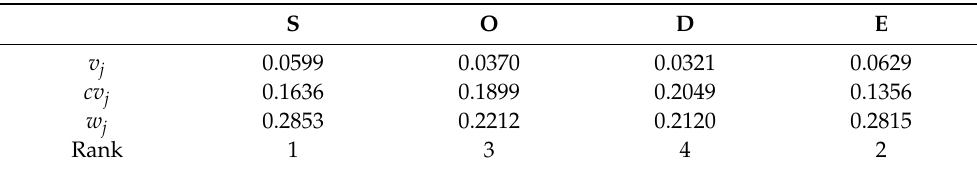
Table 7. The results obtained with the improved indifference threshold-based attribute ratio analysis (ITARA) method.